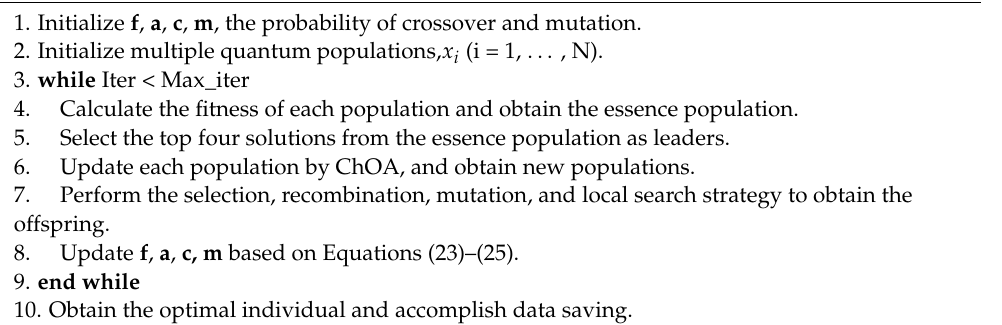
Algorithm 2 : The pseudo code of the proposed MG-ChOA